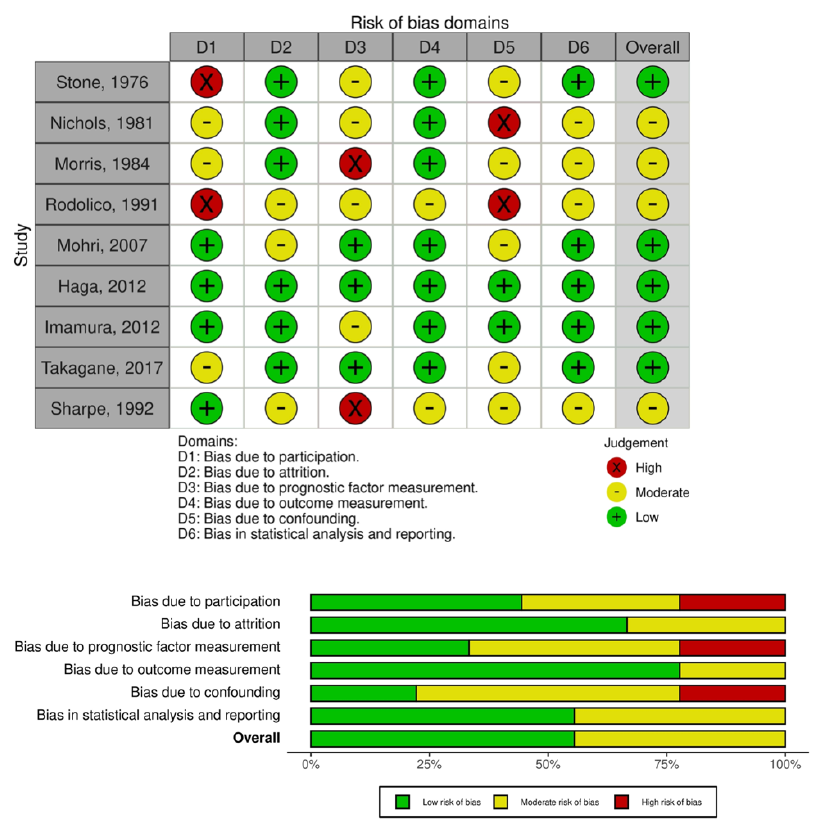
Figure 2. Risk of bias summary: traffic light plot and summary plot.